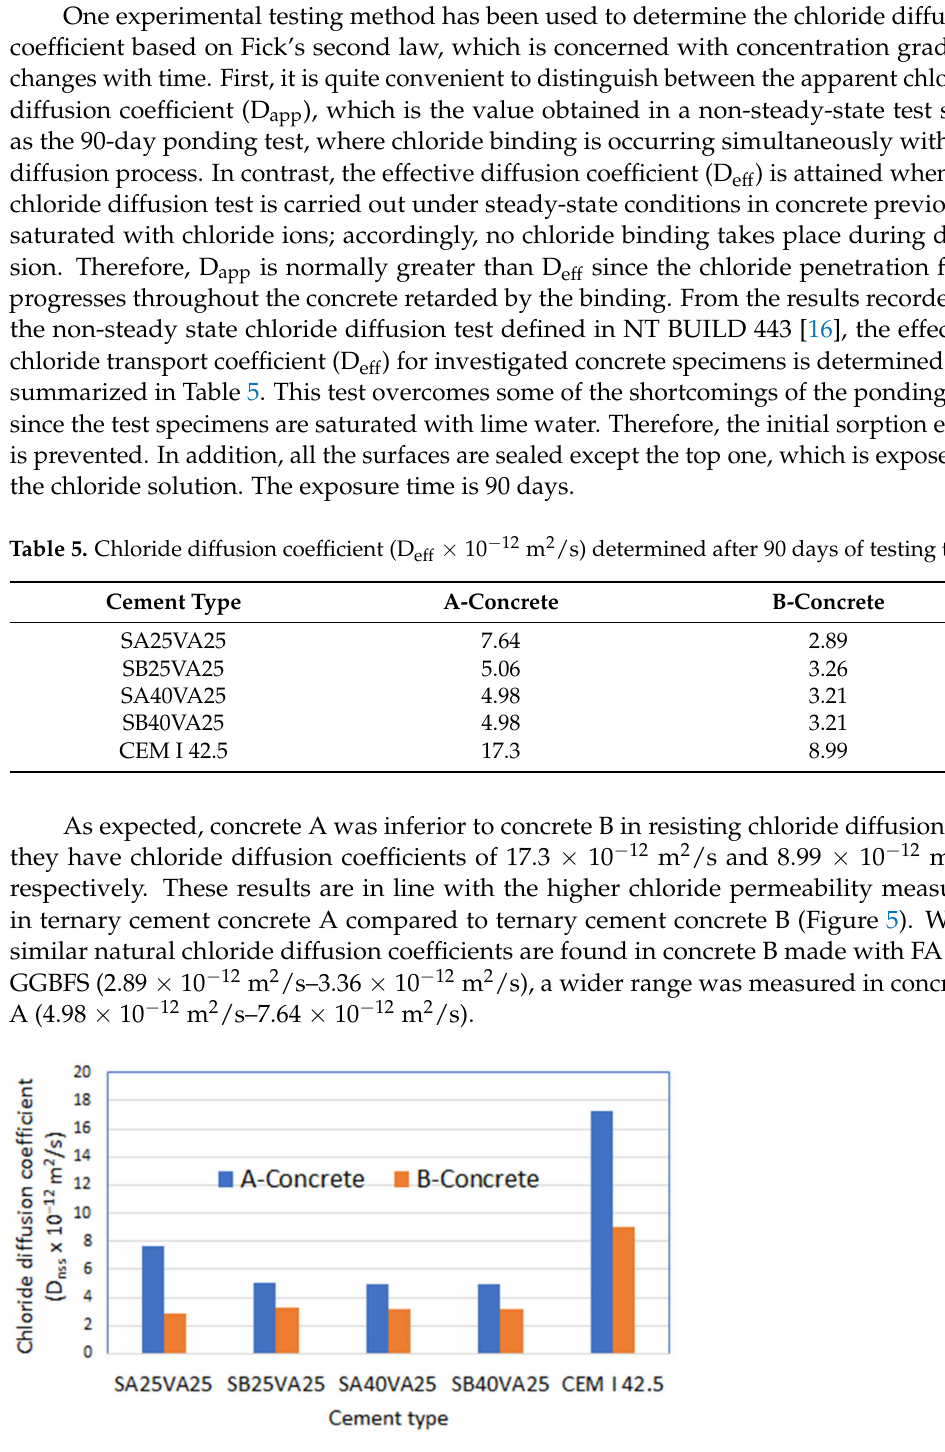
Figure 5. Chloride diffusion coefficient (D eff × 10 − 12 m 2 /s) determined after 90 days of testing